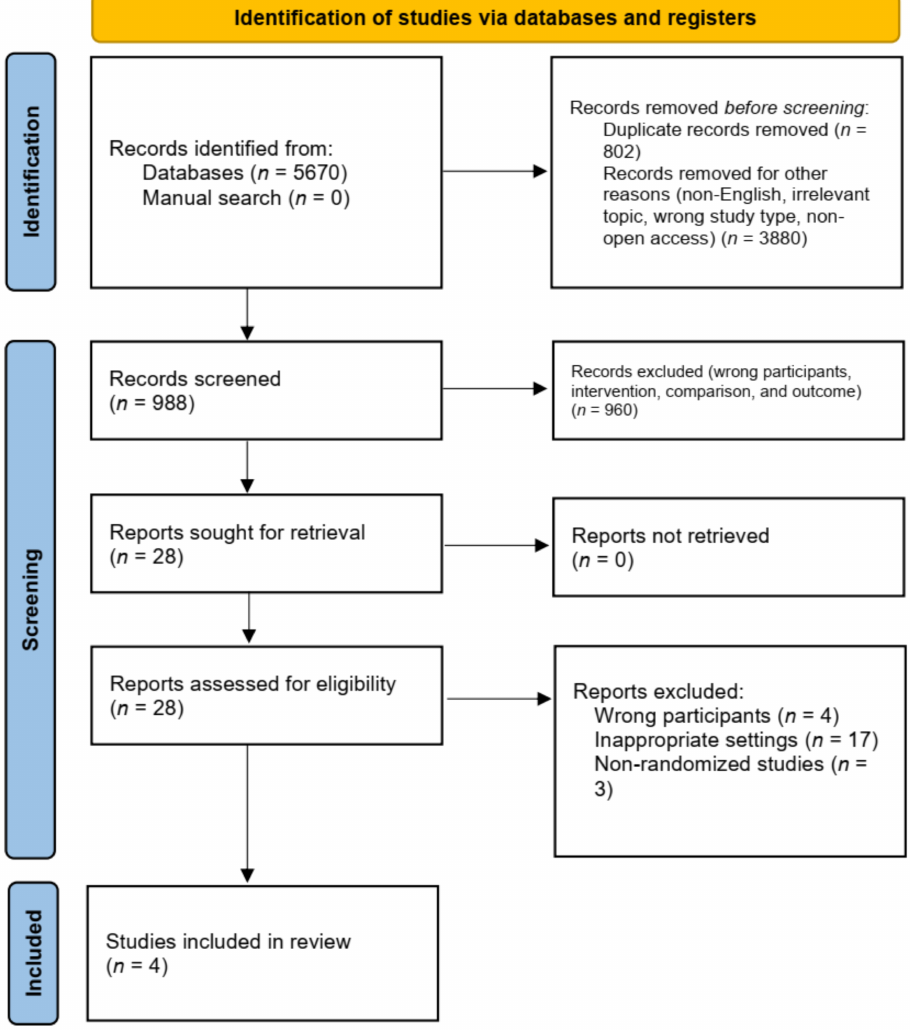
Figure 1. PRISMA flow diagram illustrating the literature search